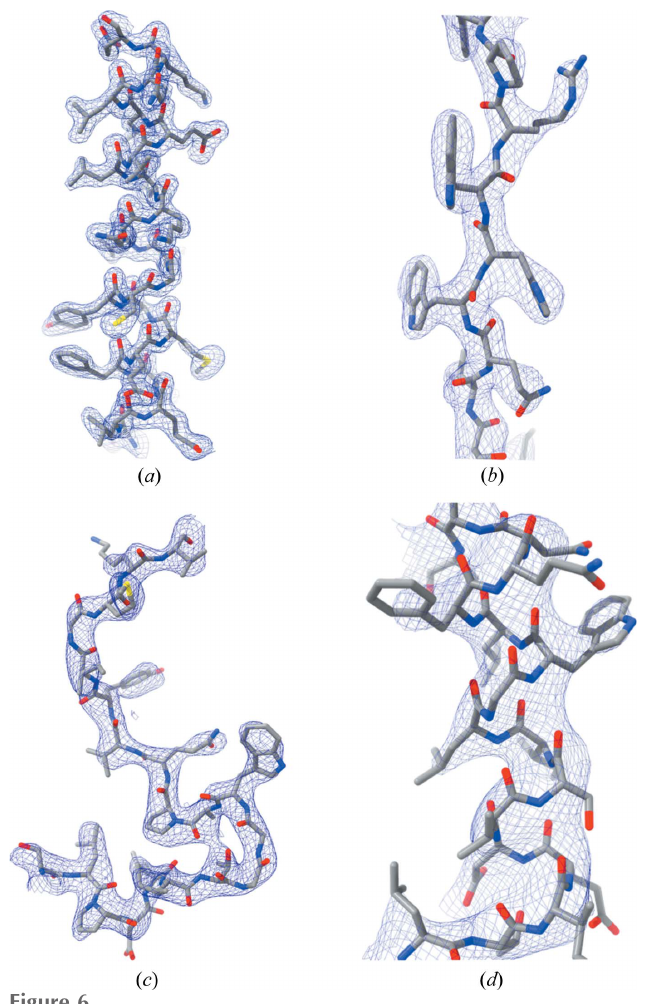
Figure 6 Details of the reconstructed electron density for selected test cases at varying resolution. ( a ) 3u6u (Sundaresan et al. , 2012) (solvent fraction 0.74, 1.92 A ˚ resolution). ( b ) 4bsj (Leppa¨nen et al. , 2013) (solvent fraction 0.74, 2.50 A˚ resolution). ( c ) 3als (Hatakeyama et al. , 2011) (solvent fraction 0.79, 3.00 A˚ resolution). ( d ) 4asn (Aylett & Lo¨we, 2012) (solvent fraction 0.76, 3.50 A˚ resolution). In each instance a portion of the reconstructed density is displayed together with the refined atonic model in stick representation. Zoning was applied to visualize the relevant subregion of each